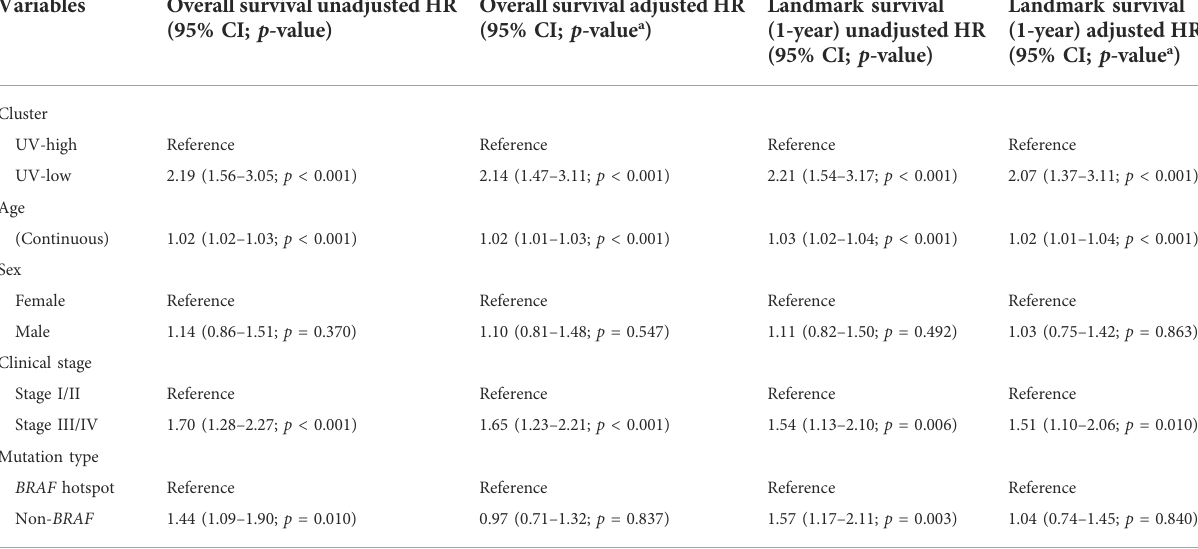
TABLE 1 Multivariate survival analysis and landmark survival at 1-year of cutaneous melanomas in TCGA.